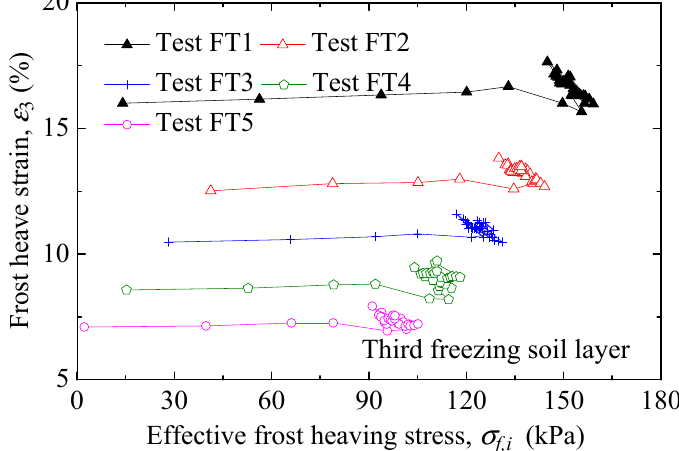
Figure 17. Frost heaving stress–frost heave strain curves at the ( a ) first freezing soil layer, ( b ) second freezing soil layer, and ( c ) third freezing soil layer.